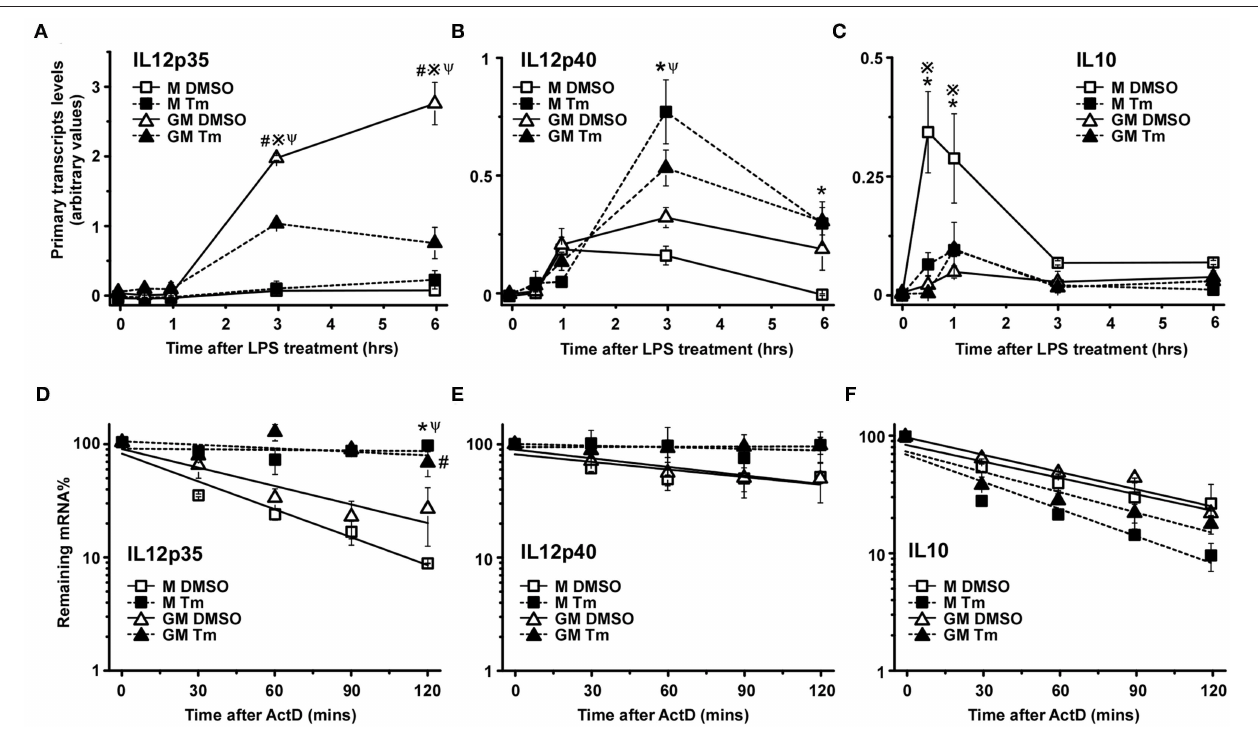
FIGURE 2 | Cellular stress modifies cytokine mRNA expression at both transcriptional and post-transcriptional levels. (A–C) M-BMDM and GM-BMDM were treated with DMSO or Tm for 6h prior to stimulation with LPS for the indicated times and total RNA was used to determine primary transcript levels of IL12p35 (A), IL12p40 (B) , or IL10 (C) by real time PCR as described in Materials and Methods. (D–F) M-BMDM and GM-BMDM were treated with DMSO or Tm for 6h and LPS for 1h prior to addition of actinomycin D (Act D, 5 µ g/ml) for indicated times. The remaining IL12p35 (D) IL12p40; (E) or IL10 (F) mRNA levels were determined by real time PCR as described in Materials and Methods . Data are presented as the mean ± SD for triplicate experiments and the differences between the indicated treatments were evaluated by two way-ANOVA and Turkey’s multiple comparisons test. P < 0.05 is indicated by * for comparison of stress vs. DMSO in M-BMDMs, by # for comparison of stress vs. DMSO in GM-BMDMs, by ※ for comparison of M DMSO vs. GM DMSO and by 9 for comparison of M-BMDM stress vs. GM-BMDM